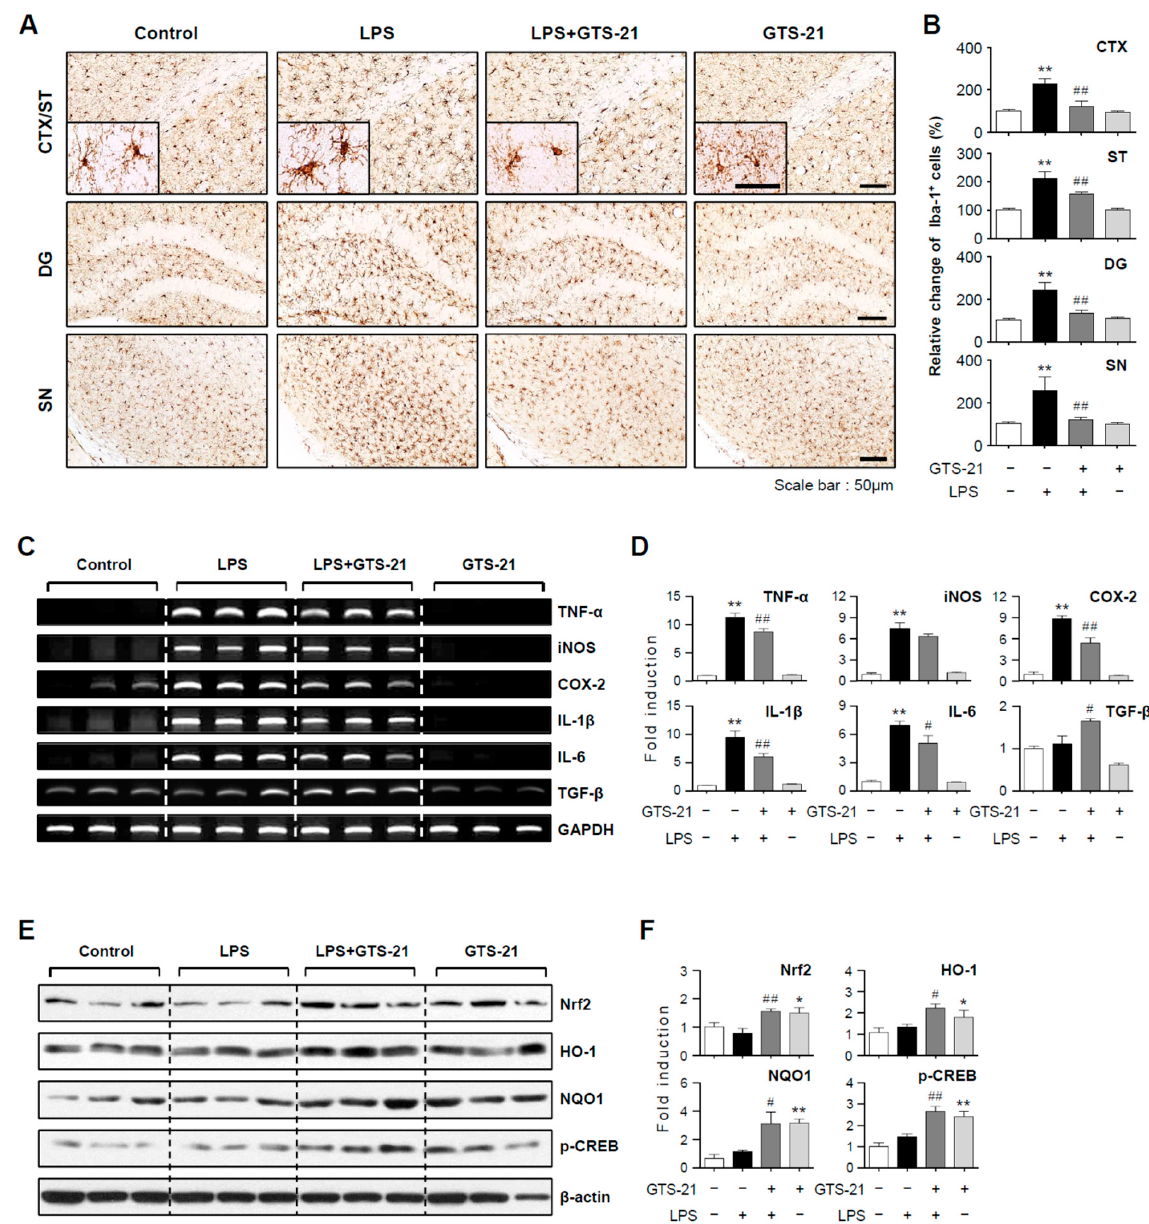
Figure 6. Effect of GTS-21 on microglial activation, inflammatory markers, and antioxidant signal- ing molecules in the brains of LPS-injected mice. ( A , B ) Iba-1 immunohistochemical staining and quantification of Iba-1-positive microglia 24 h after LPS injection ( n = 4 per group, 3 sections/brain). GTS-21 (5 mg/kg) reduced microglial activation in the prefrontal cortex (CTX), striatum (ST), dentate gyrus of the hippocampus (DG), and substantia nigra (SN) of LPS-injected mice. Data quantification ( B ) and representative images ( A ) are shown. Scale bars, 50 µ m. ( C , D ) Effects of GTS-21 on iNOS, COX-2, and cytokines mRNA levels in the cortices of LPS-injected mice ( n = 3). The quantification data ( D ) and representative gels ( C ) are shown. ( E , F ) Western blot analysis was performed on protein extracts from the cortex of each group using Nrf2, p-CREB, HO-1, and NQO1 antibodies ( n = 4–5 per group). Representative blots ( E ) and quantification data ( F ) are shown. The data are presented as the mean ± SEM. * p < 0.05, vs. control group; ** p < 0.01, vs. control group; # p < 0.05 vs. LPS-treated group; ## p < 0.01 vs. LPS-treated